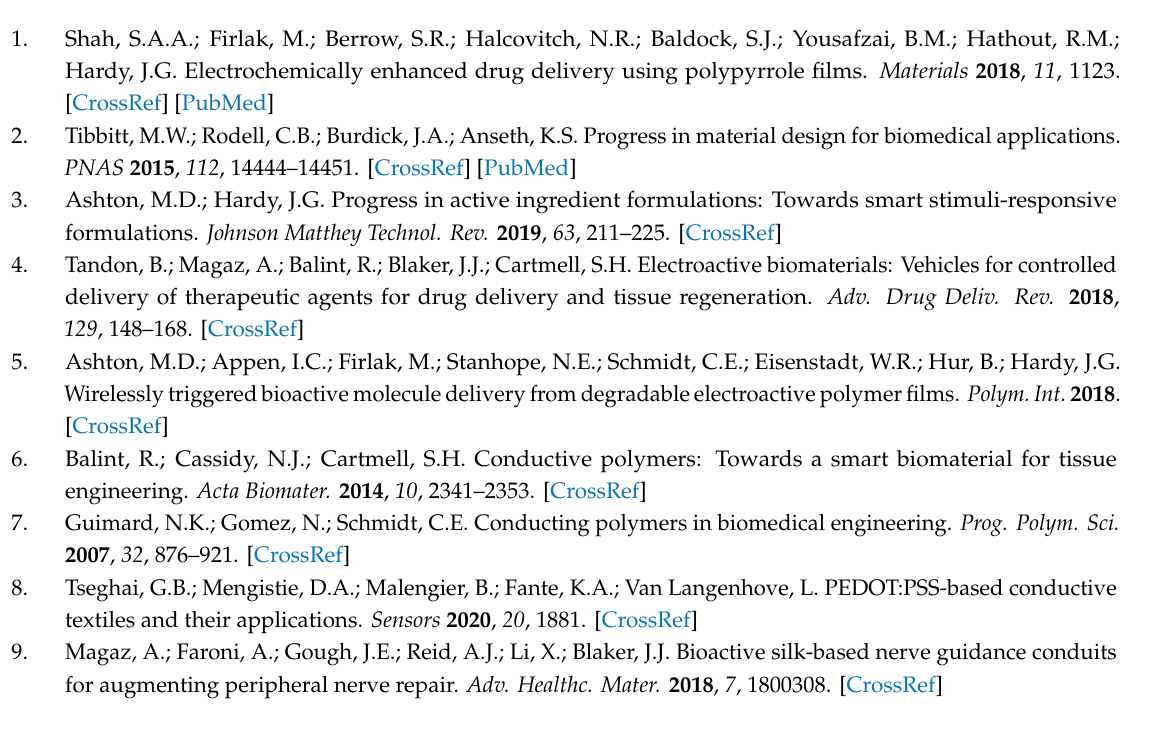
Figure S1: FTIR-ATR spectrum of the electroconductive / active silk-based films. Figure S2: Zoomed-in cumulative NGF- β release (passive release) from the films. Figure S3: Electrical stimulation paradigm. Table S1: Molecular descriptors. Table S2: Molecular-input line-entry system notations of the nanomaterials and molecules